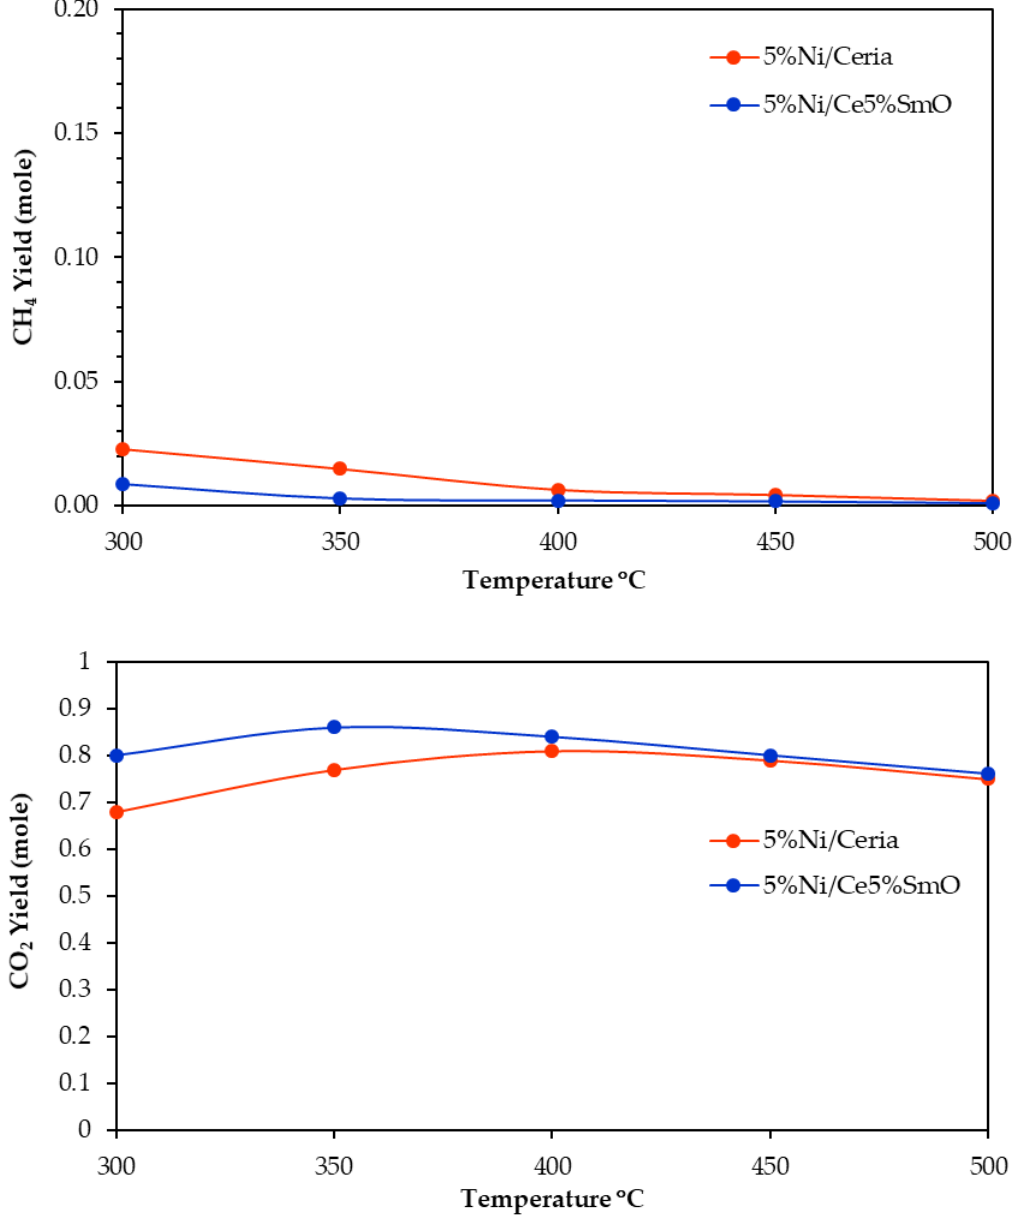
Figure 6. The effect of temperature on the CO 2 and CH 4 yield of water gas shift reaction. The WGS reaction stability of Ni/CeO 2 and Ni/Ce5%SmO prepared by the combus- tion method was tested at 280 °C under the feed gas composition of 5%CO, 10% H 2 O and balance N 2 . As shown in Figure 7, the conversion of 5%Ni/CeO 2 decreased from 47% to 36% after 60 h of the water gas shift reaction test whereas 5%Ni supported on Ce5%SmO mixed oxide support retains a high water gas shift stability for the whole period of 60 h. Therefore, the addition of Sm improved both WGS activity and stability of the Ni catalysts.